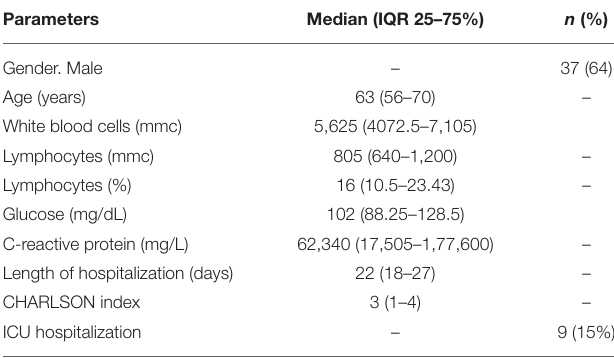
TABLE 1 | Demographic and clinical characteristic of study population at